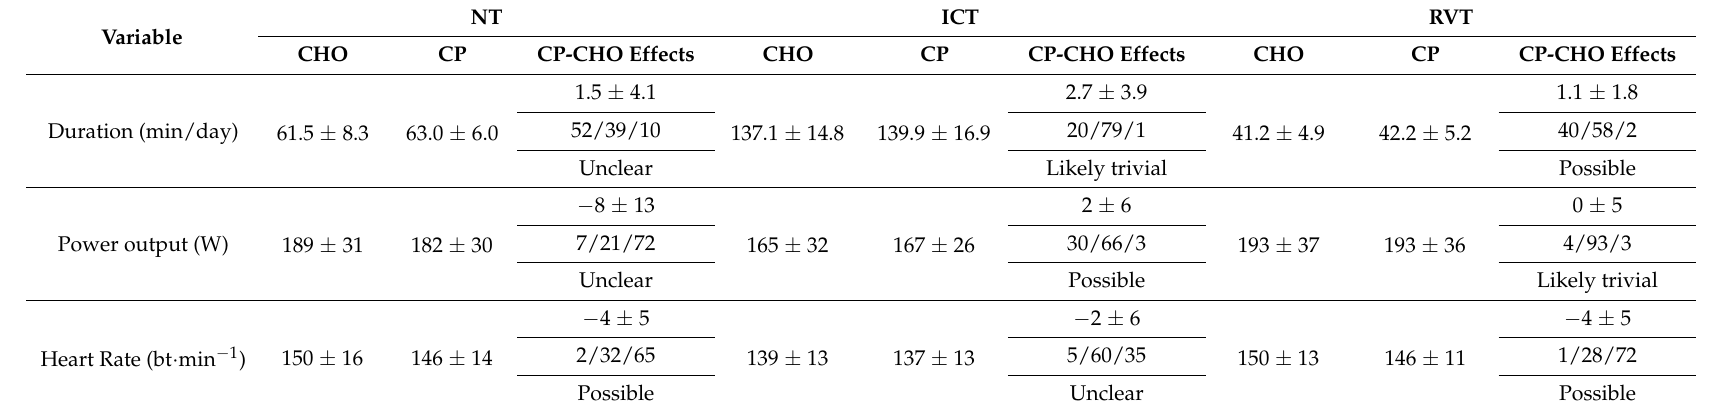
Table 1. Training Loads (Mean ± SD) during Normal, Intensified, and Reduced-Volume